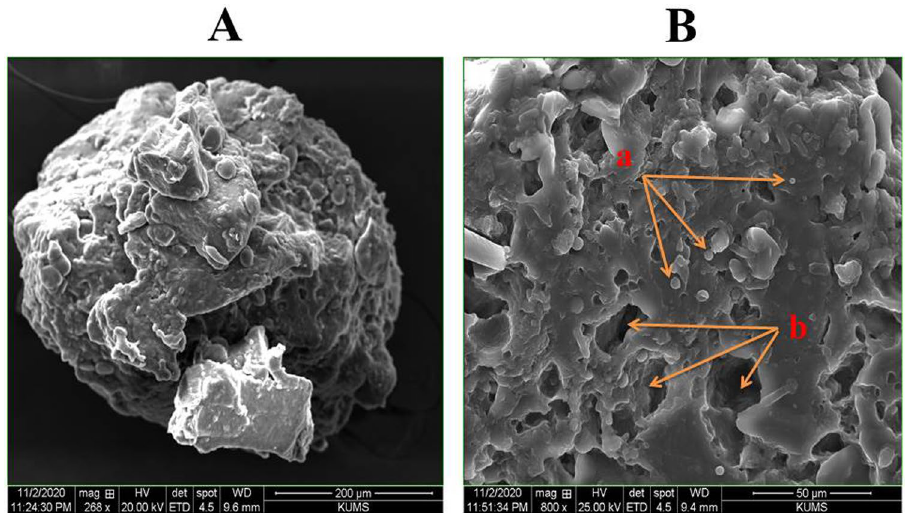
Figure 1. Morphological images of probiotic drop with Tarkhineh texture by the scanning electron microscopy (Hitachi SU3800): ( A ) spherical shape probiotic drop and their protective layers for the probiotic cells, ( B ): (a) network-like structures of Tarkhineh texture and entrapped probiotic cells and (b) tiny pores on the surface of Tarkhineh